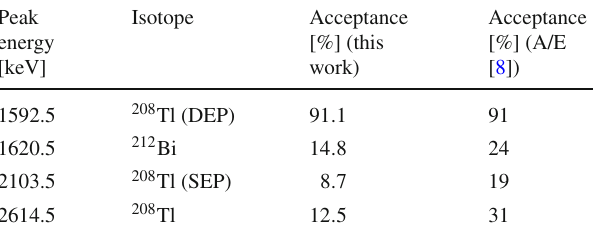
Table 3 Acceptance of the selected peaks from the 228 Th spectrum in comparison with A/E method from [8] (cut applied: MLP value > 0.56, DEP events acceptance at ≈ 91%, DEP/FEP training scenario) Peak